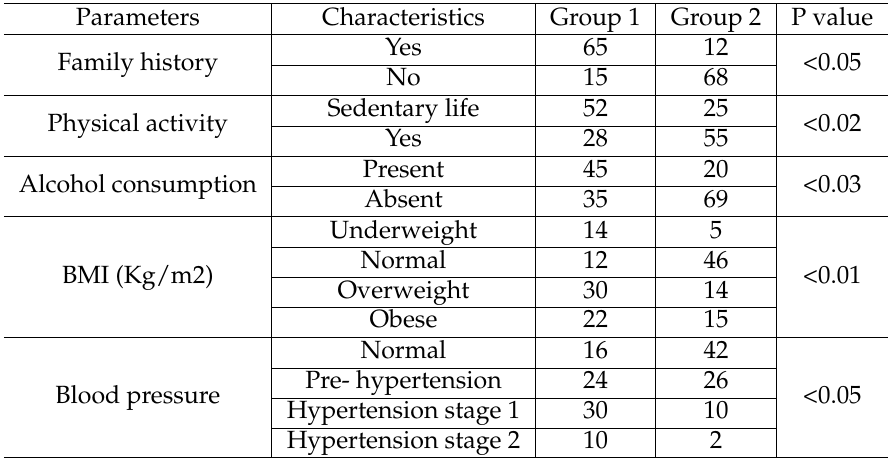
Table 2. Patient